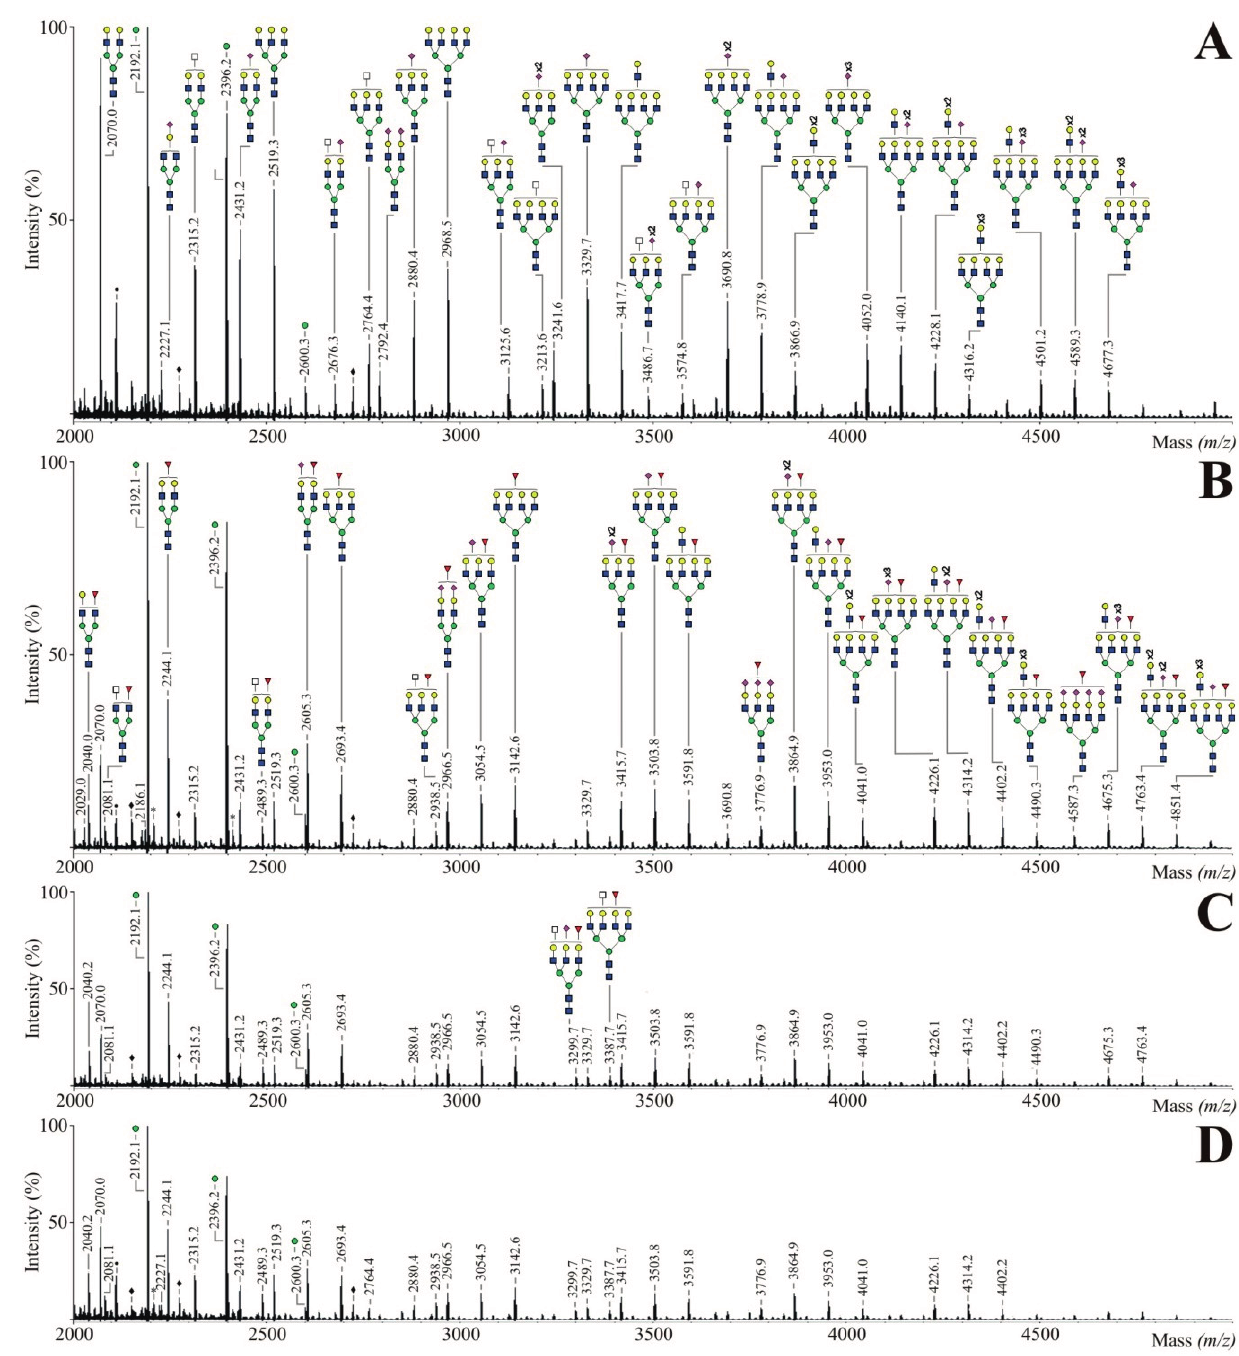
Figure 4. MALDI-TOF mass spectra of permethylated N -glycans of total CHO RMD cell membrane proteins after three-day treatment with 80 µM of Ac 4 Fuc ( B ), Prop 4 Fuc ( C ) or PEG 4 Fuc ( D ) under serum-free culture conditions; in comparison to an untreated control ( A ). Membrane-bound N -glycans were enzymatically released by N -glycosidase F. Molecular ions are present in either sodiated [M + Na] + or potassiated [M + K] + form (*). Highmannose N- glycans are marked by a green circle, polyhexose contaminations by a black ring (•) and unidentified peaks by a black diamond ( ♦ ). All signals with relative peak areas higher than 0.5% are labeled with their respective numerical m/z -values. Graphical visualization of all structures is only done once per m/z in the whole Figure ( A – D